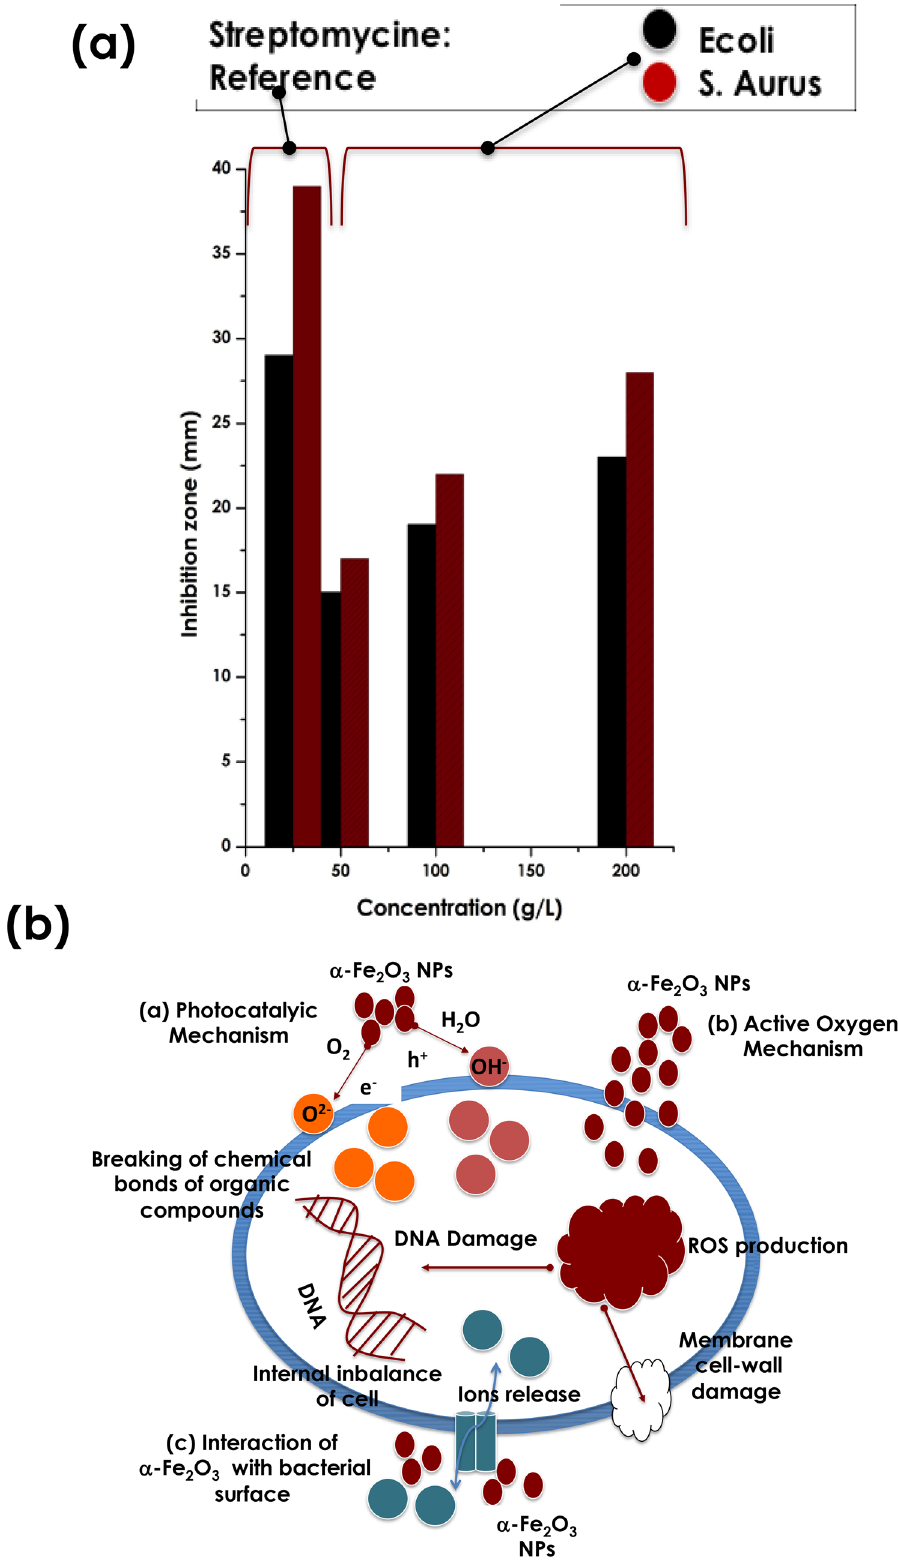
Figure 5. ( a ) Antibacterial response of the Red Ochre pigment against the E-coli & S-Aurus compared to standard reference Streptomycine ( b ), Schematic representation of the 3 potential mechanisms inducing the antibacterial activity of the